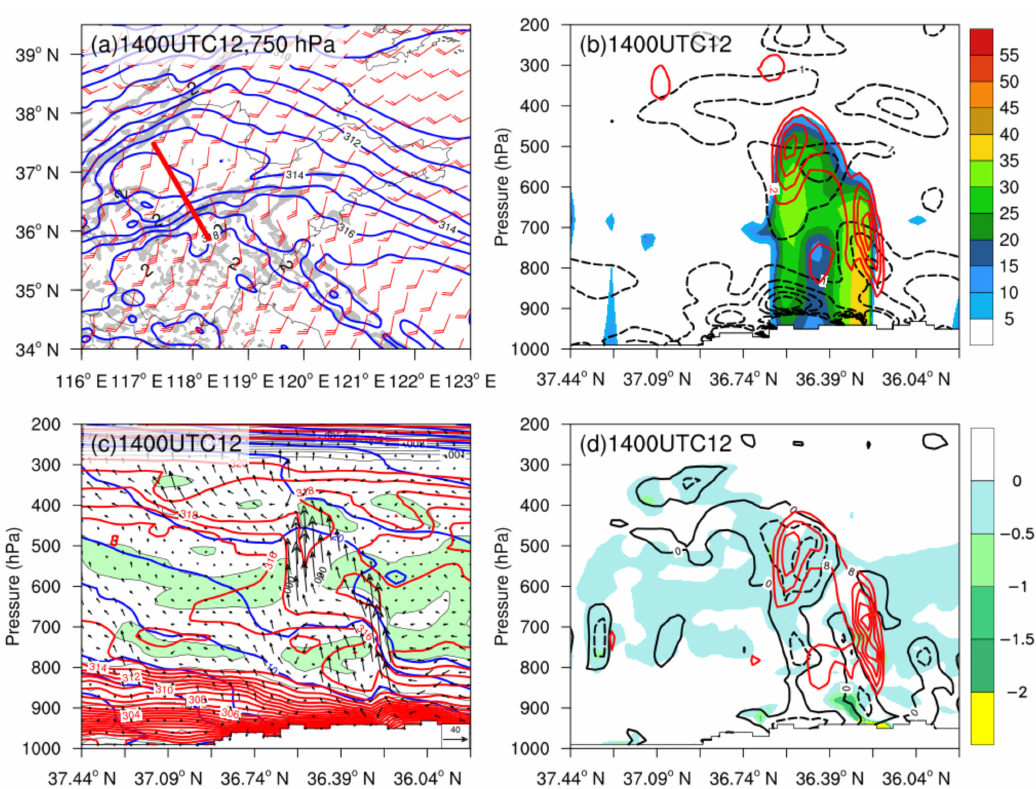
Figure 11. As in Figure 10, but for the 4 km run valid at 1400 UTC 12 February 2016.